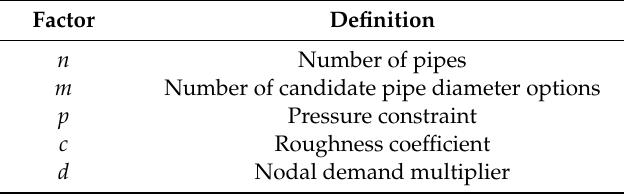
Table 1. Factors that were altered in the generation of engineering benchmark